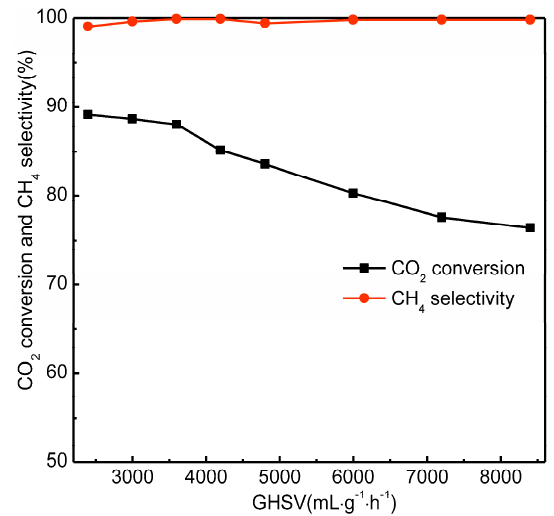
Figure 8. Effect of GHSV on catalytic CO 2 methanation of Ni/bentonite-U and Ni-2wt%Mn/bentonite-U catalysts. Reaction conditions: atmospheric pressure, T = 300 °C, V (H 2 )/ V (CO 2 ) = 4.